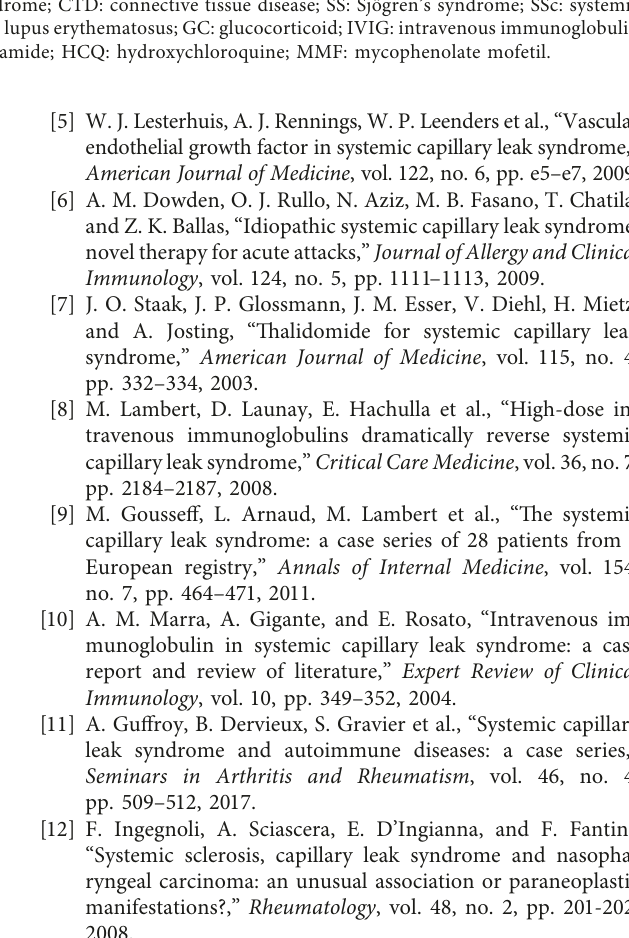
Table 2: Characteristics of SCSL with CTD. Treatments before